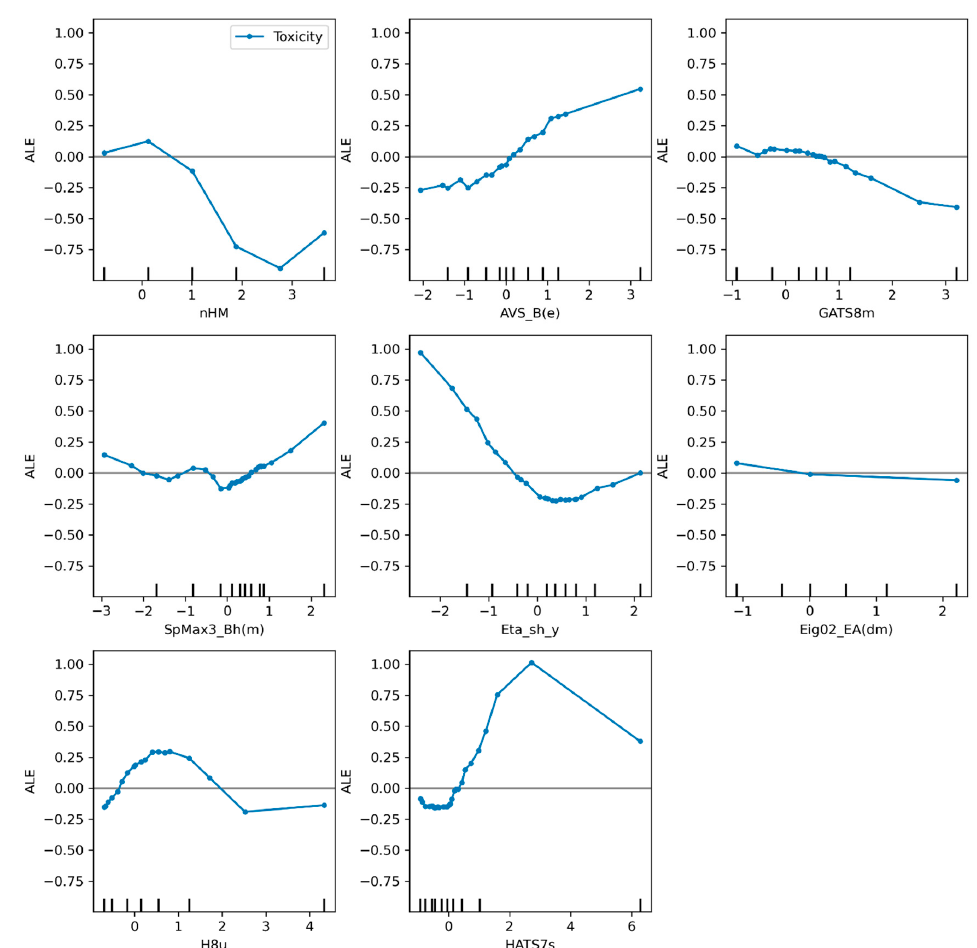
Figure 6. Descriptors weights represented by ALE plot for the SVR_B model.